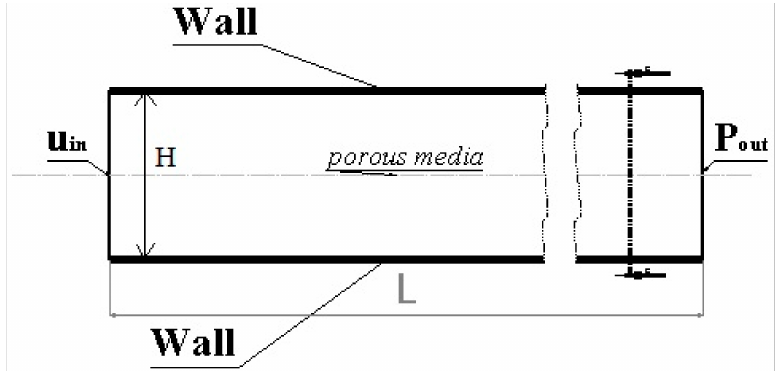
Figure 1. The schematic diagram of the modeling structure.